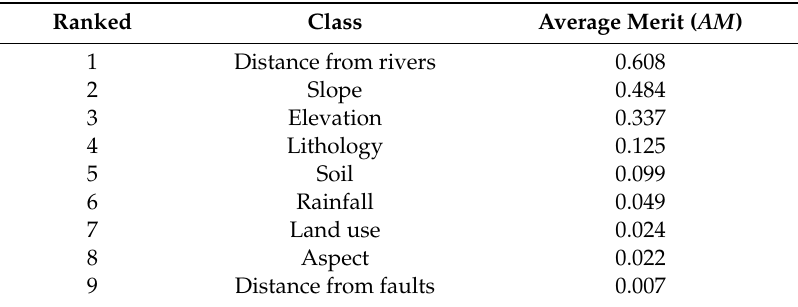
Table 4. Importance of factors using correlation based feature selection.